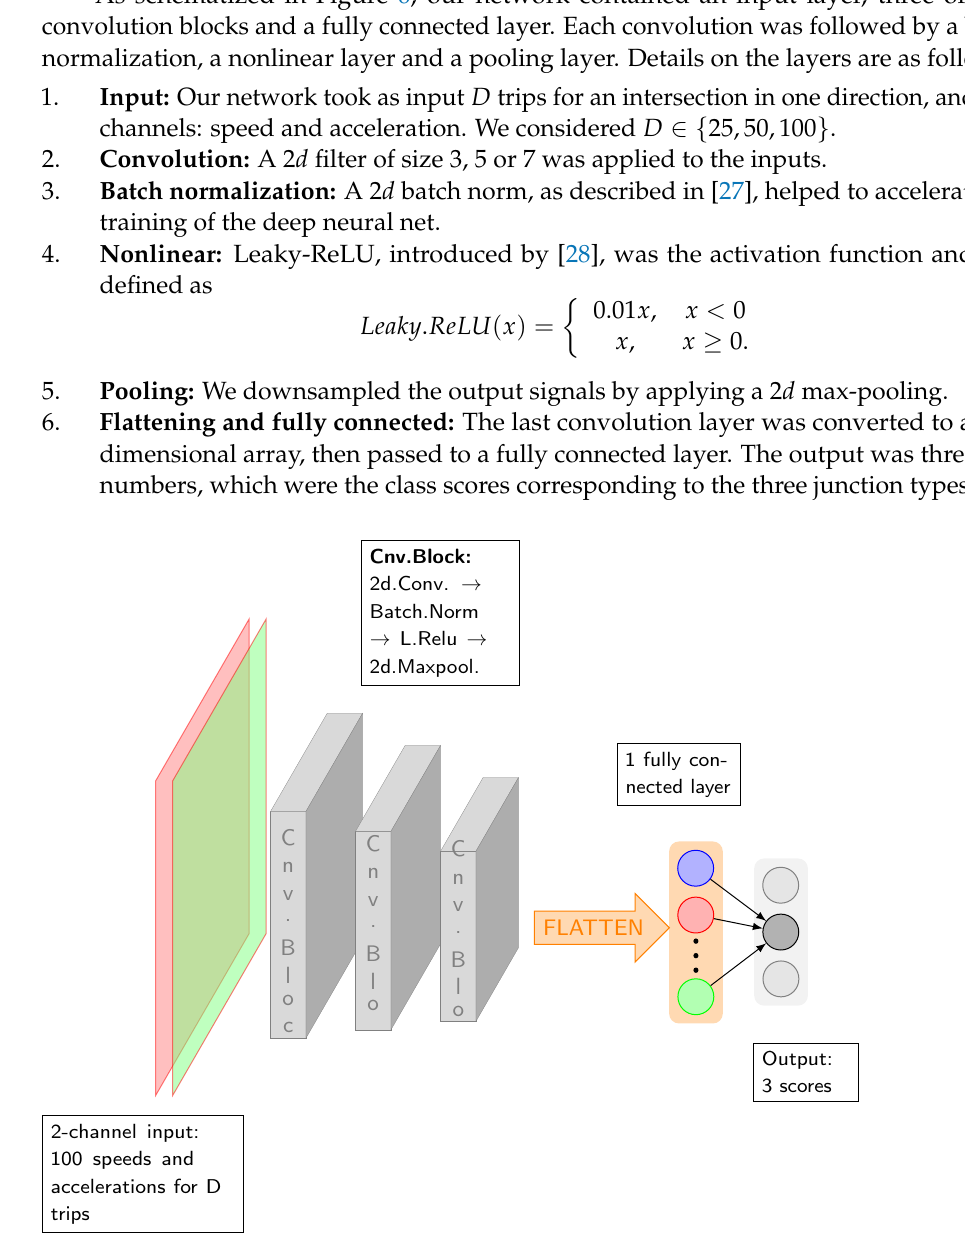
Figure 6. CNN model architecture for characterizing TCEs at an